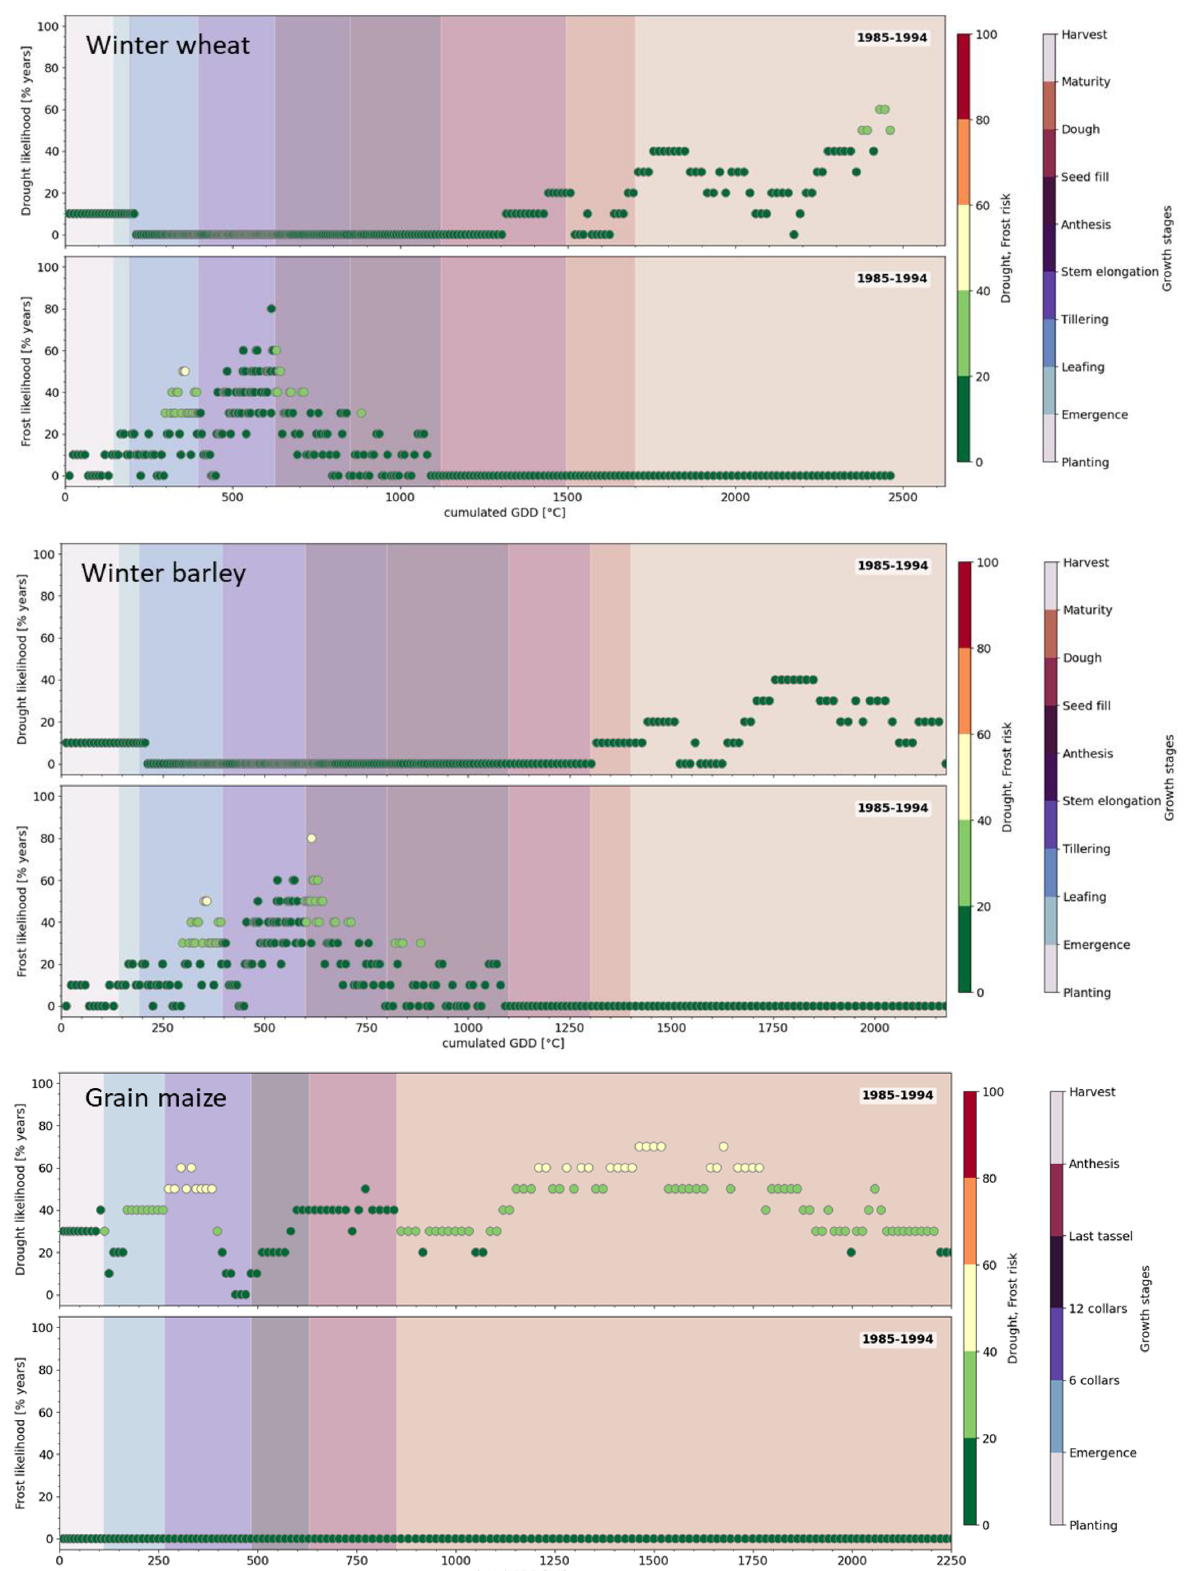
Figure 2. Drought and frost risk for winter wheat, winter barley and maize in Belgium,